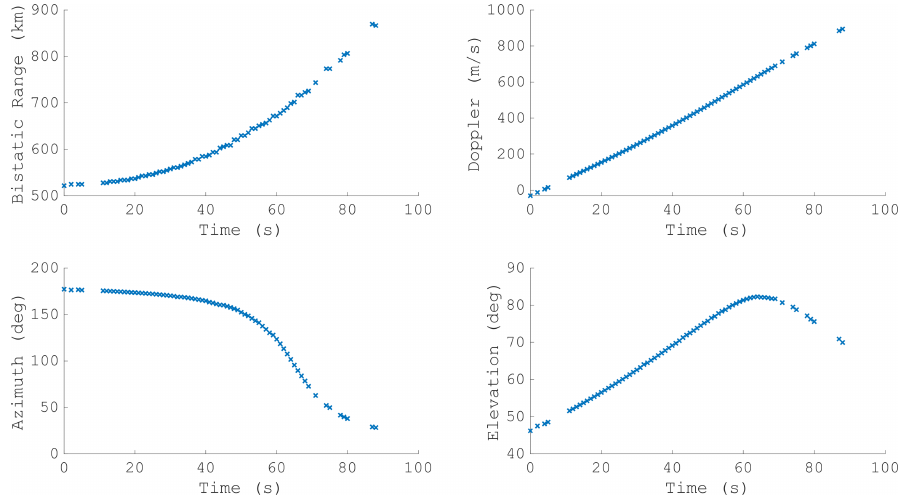
Figure 13. The four measurement parameters from the detections of an outbound COSMOS 1707 detected using an FM transmitter in Albany.